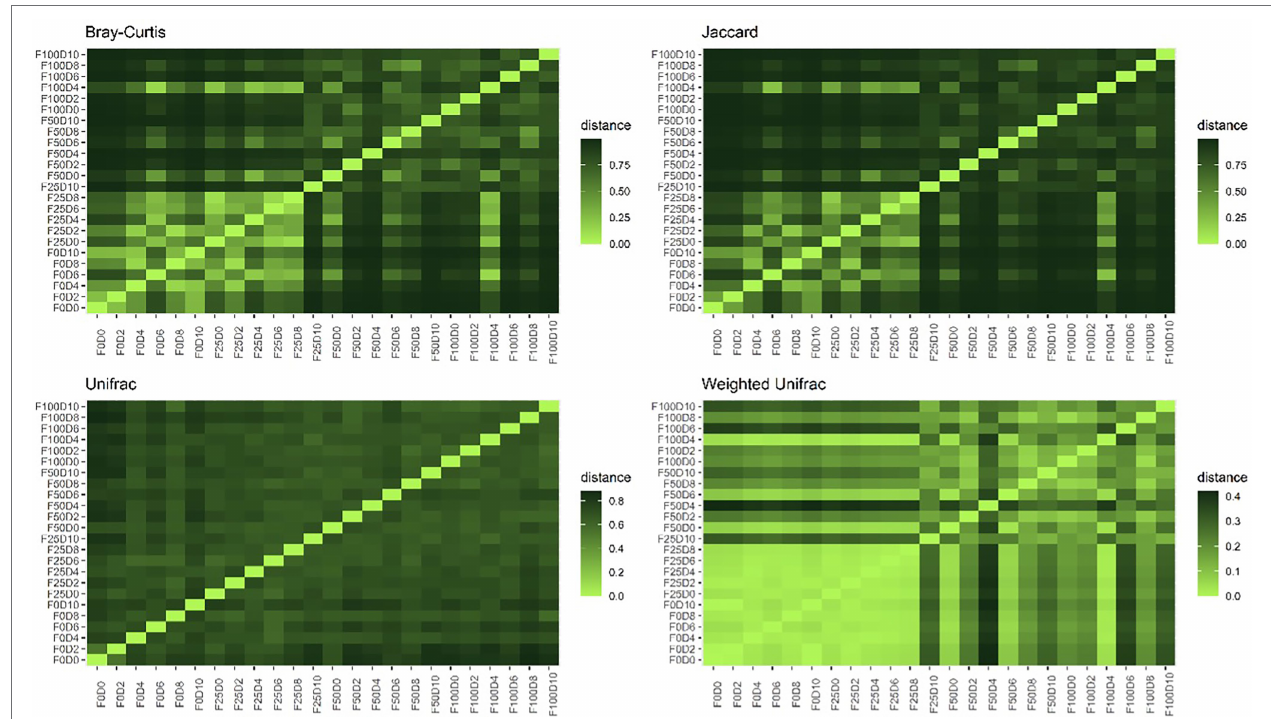
FIGURE 3 | Proportion of dissimilarity – beta diversity based on Bray–Curtis, Jaccard, UniFrac and Weighted UniFrac metric distances for the 24